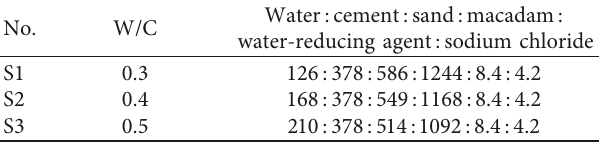
Table 1: Mix proportion of concrete (kg/m 3 ).